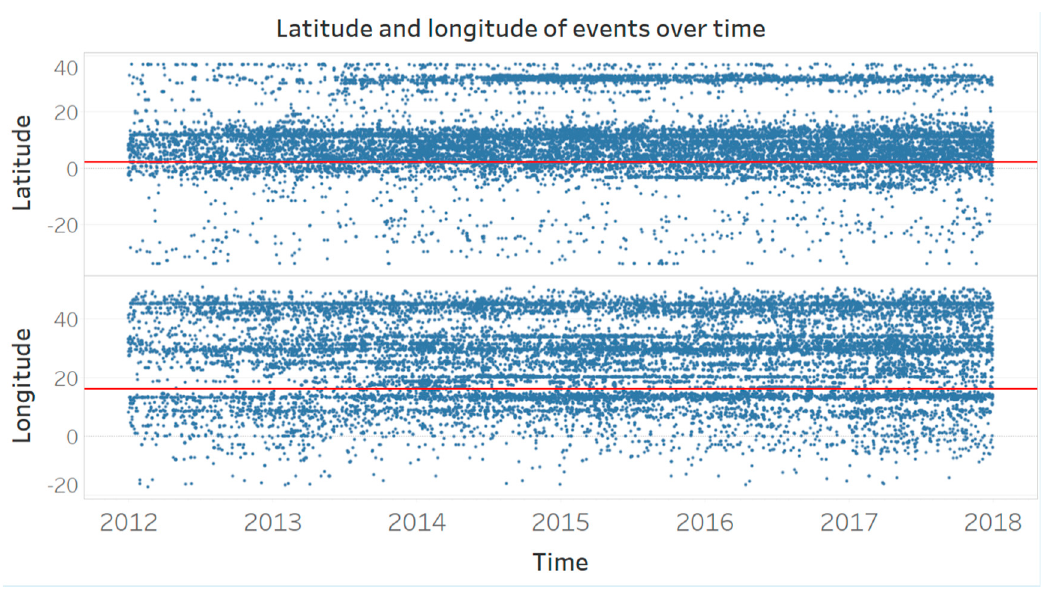
Figure 3. The latitude and longitude of events over time. The red lines represent the latitude and longitude of the geographical center of Africa. In the latitude plot, points above the red line are more north and points below are more south. In the longitude plot, points above the red line are more east and points below the red line are more west.